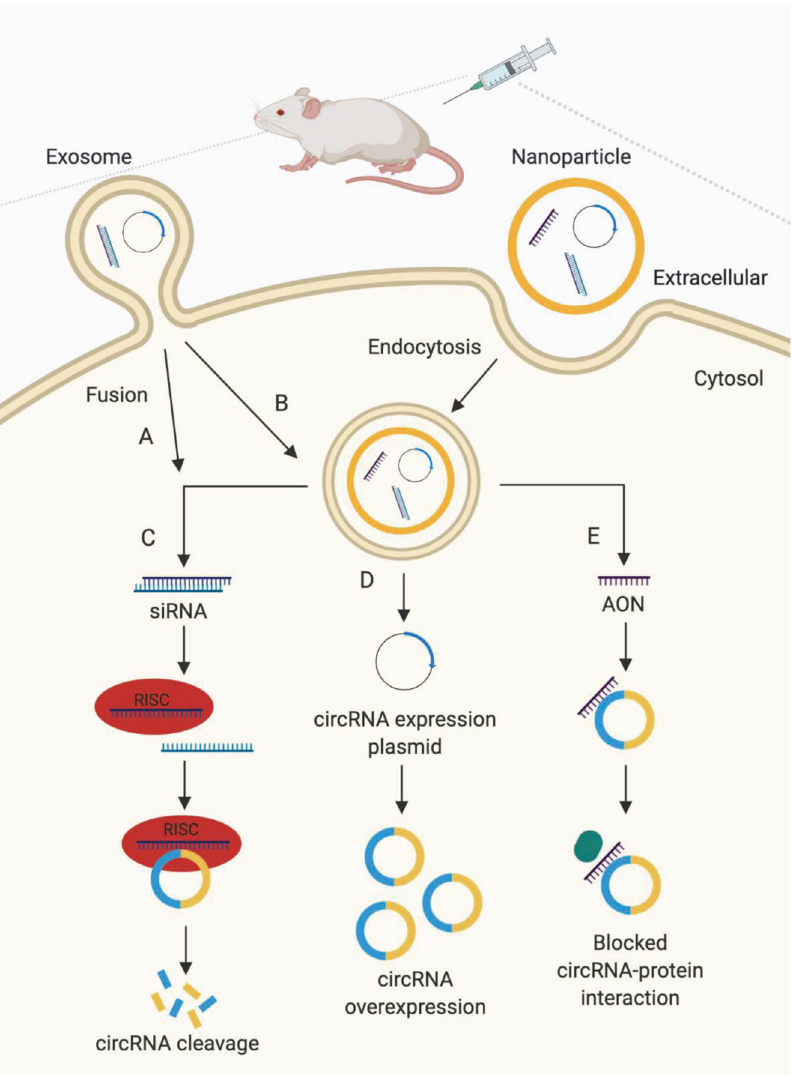
Fig. 3 Strategies used to target circular RNAs (circRNAs) as a therapeutic approach in vivo. A, B Exosome-mediated delivery of A short interfering RNA (siRNA) targeting the back-splice junction of circRNAs to induce circRNA cleavage and B circRNA expression plasmid to overexpress circRNAs. C – E Gold nanoparticle-mediated delivery of C siRNA targeting the back-splice junction of circRNAs, D circRNA expression plasmid, and E antisense oligonucleotide (AON) blocking protein interaction site on